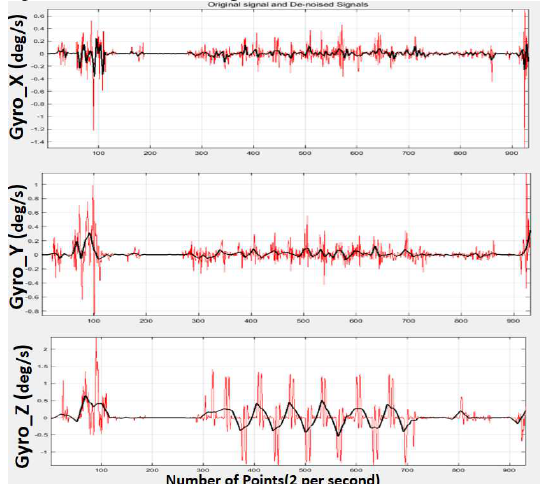
Figure 10. Acceleration graphs of data obtained during UAV flight